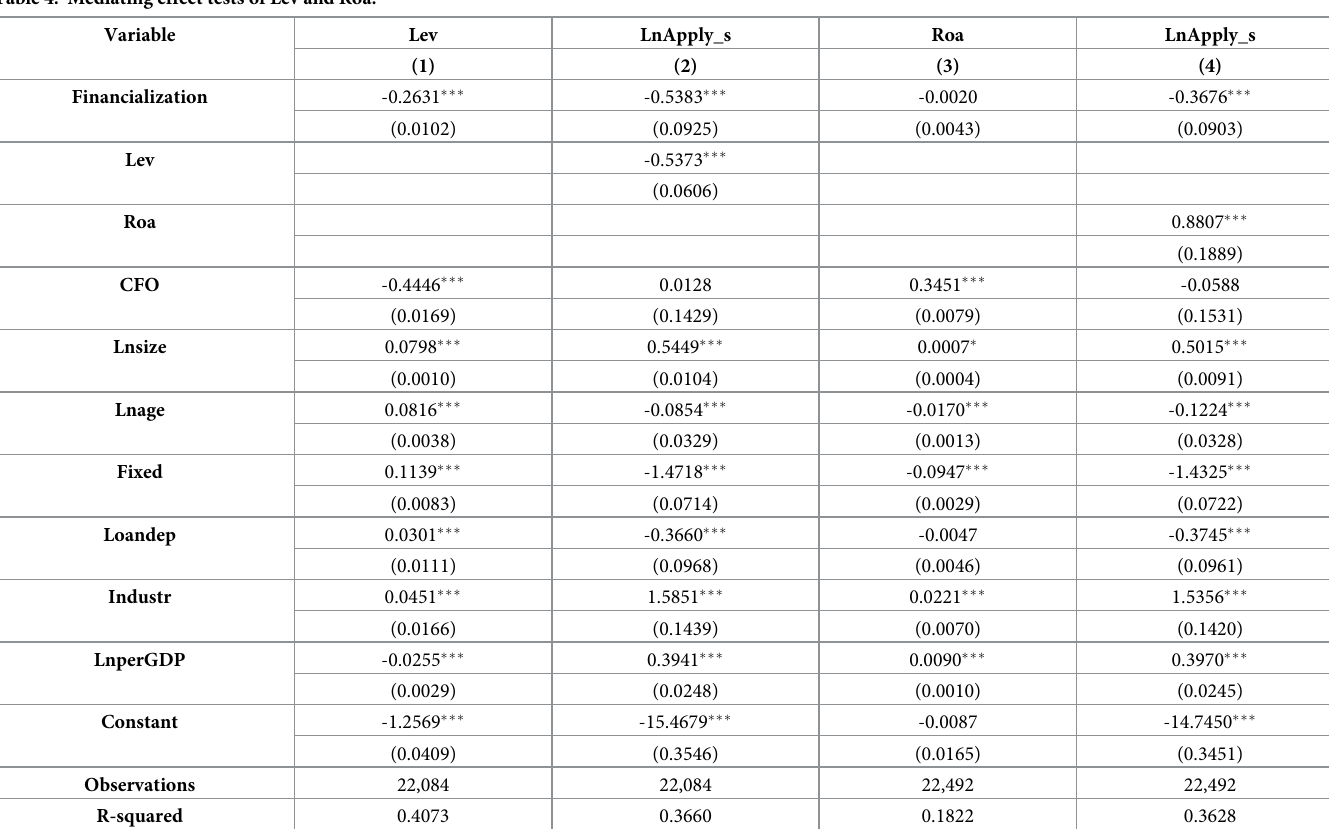
Table 4. Mediating effect tests of Lev and